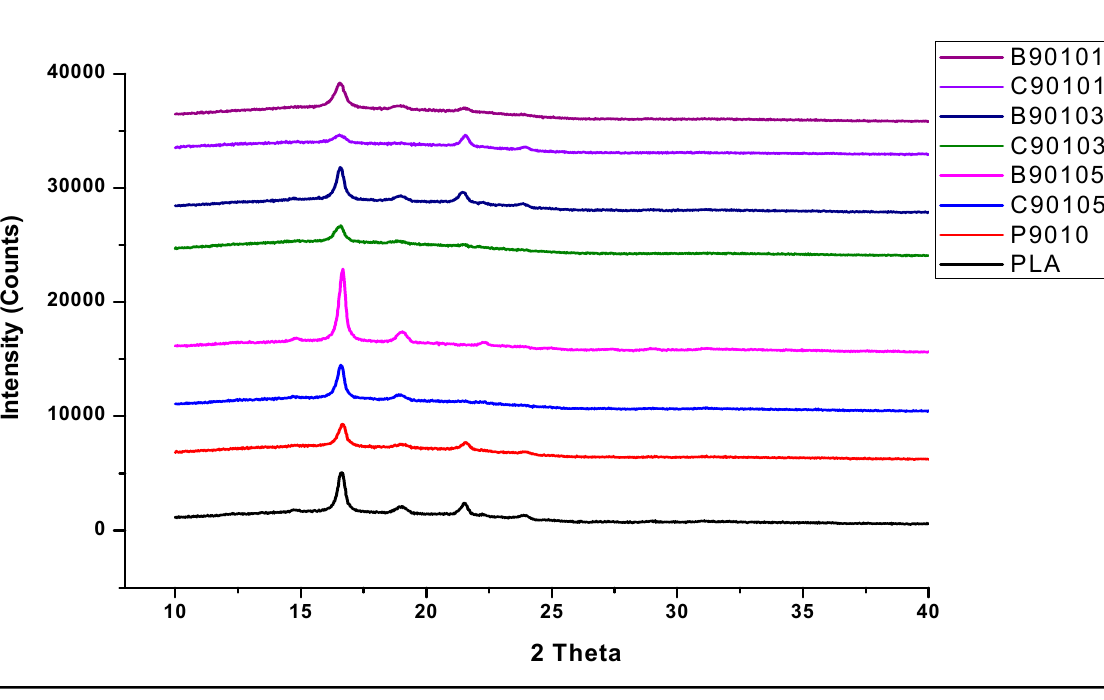
Figure 7. Comparative analysis of X ‐ ray diffraction analyses of bamboo and commercial CNF ‐ reinforced biocomposite.